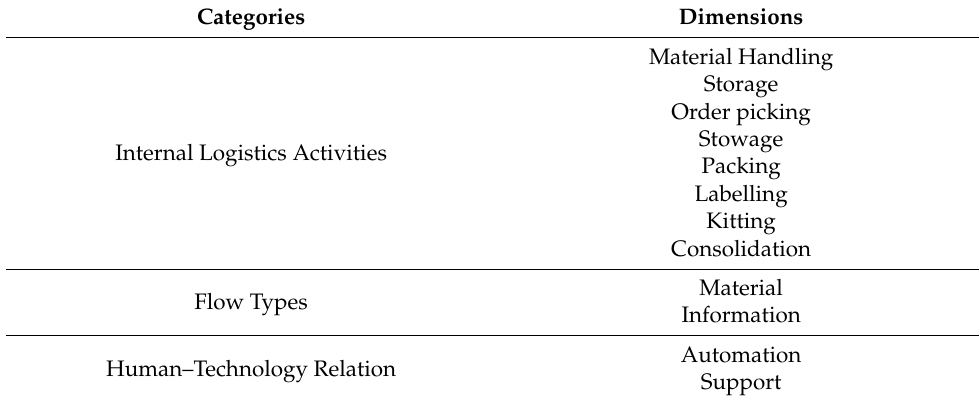
Table 4. Taxonomy categories and dimensions.